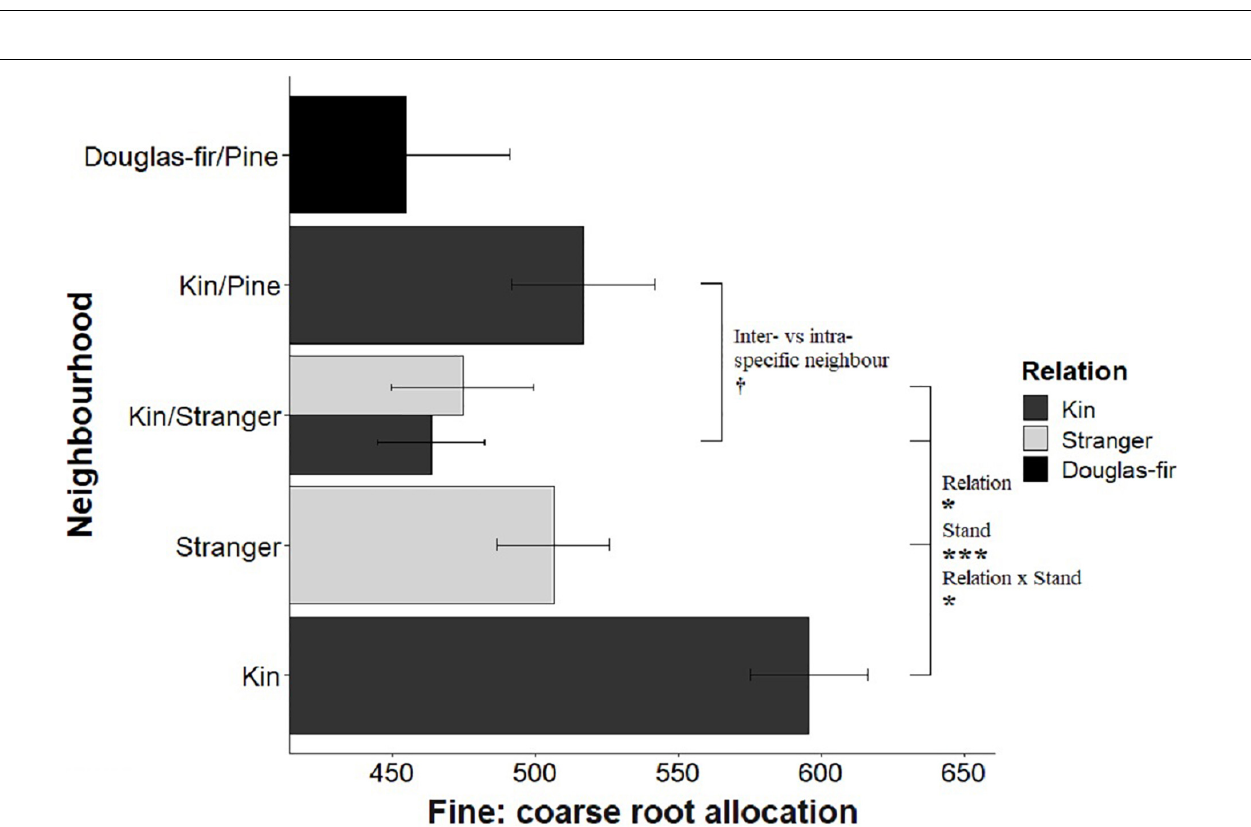
FIGURE 7 | Estimated marginal means from planned contrasts ( Table 2 ) relation (estimate = –78.6, t ratio = –1.99, p = 0.0475, Df = 196), stand (estimate = 164, t ratio = 3.63, p = 0.0004, Df = 196), inter- vs. intraspecific neighbor (kin pair with intra- or interspecific as the neighbor) (estimate = 53.3, t ratio = 1.85, p = 0.0653, Df = 196) and presence and number of pine seedlings (not significant) on the linear model fine root allocation: fine ∼ poly(coarse, 2) + Neighborhood × Family. * p < 0.05, *** p < 0.001, and † p < 0.1.